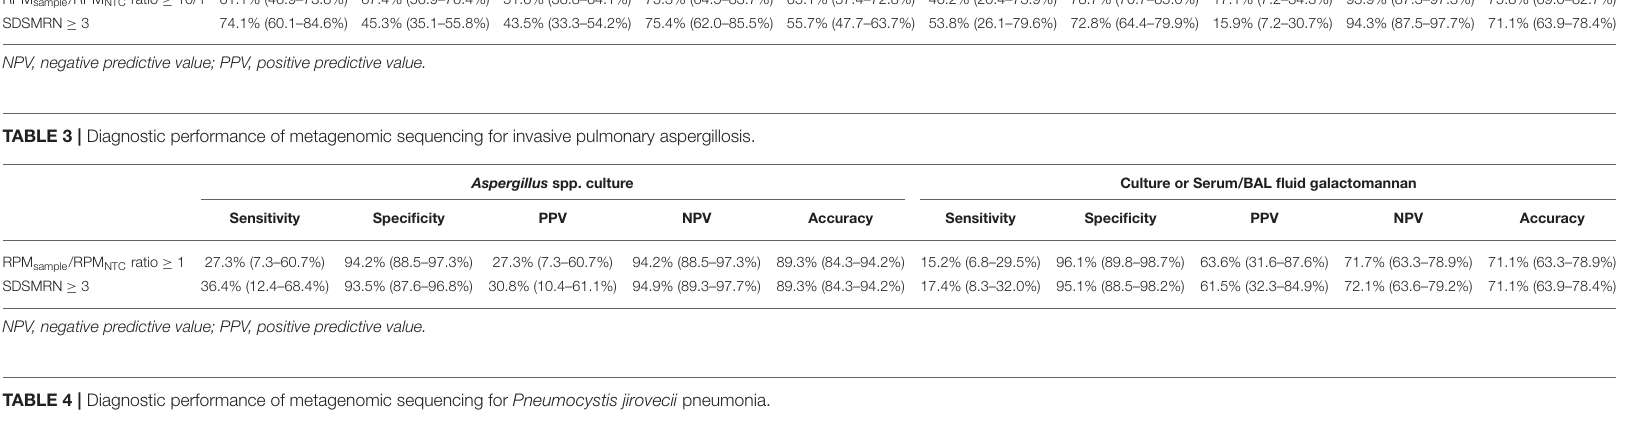
TABLE 2 | Performance of metagenomic sequencing for bacterium and fungus detection. Bacteria culture Fungi culture Sensitivity Specificity PPV NPV Accuracy Sensitivity Specificity PPV NPV Accuracy